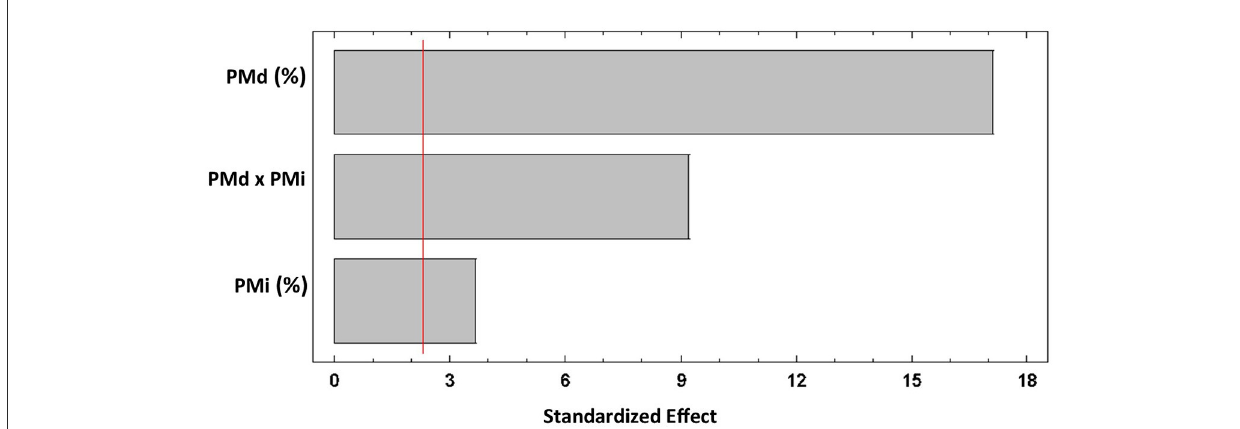
FIGURE4 Pareto diagram shows the effect of the percentage of pulp M. indica and M. dubia on the antioxidant capacity of ice cream. PMd, M. dudia pulp; PMi, M. indica pulp.